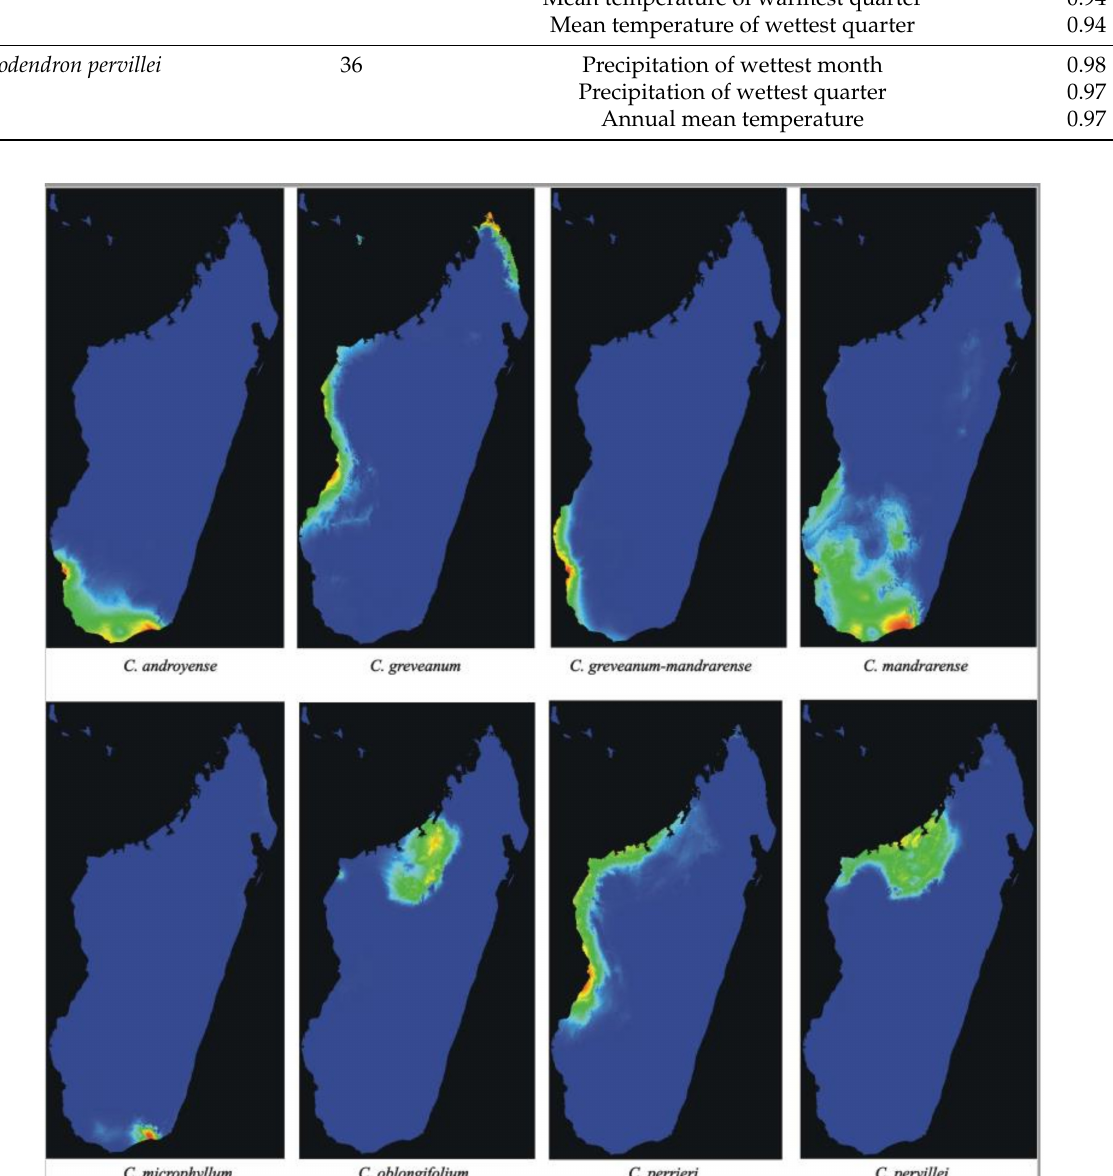
Figure 6. Potential distribution maps predicted by Maxent for Capurodendron androyense , C. greveanum , C. greveanum-mandrarense , C. mandrarense , C. microphyllum , C. oblongifolium , C. perrieri and C.